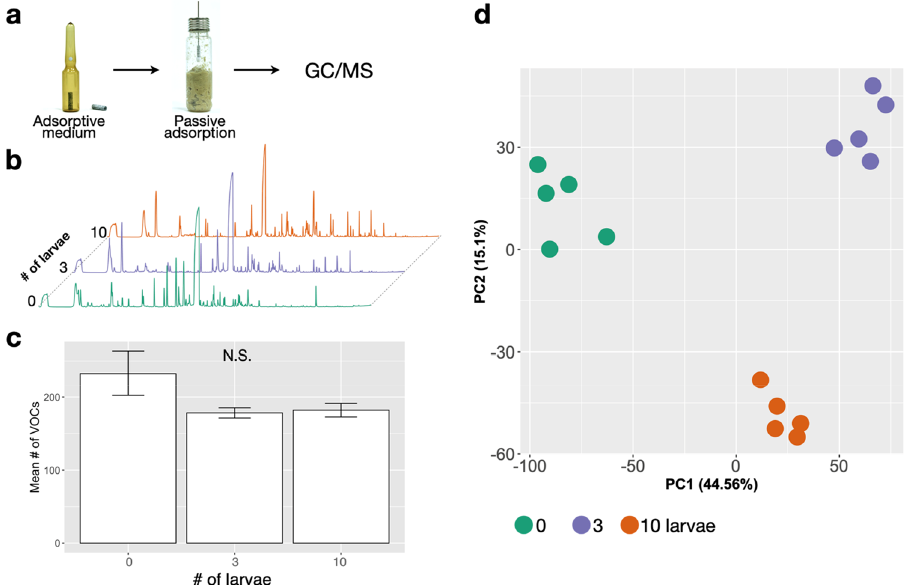
Figure 2. Overview of thermal desorption gas chromatography mass spectrometry (TDU-GC/MS) analysis of food waste. ( a ) Adsorptive medium and its use for adsorption of odor components. ( b ) Typical total ion chromatograms. ( c ) Mean number of volatile organic compounds. Mean number of components did not differ significantly (N.S.) between treatments (ANOVA). ( d ) Principal component (PC) analysis of odor components by treatment.